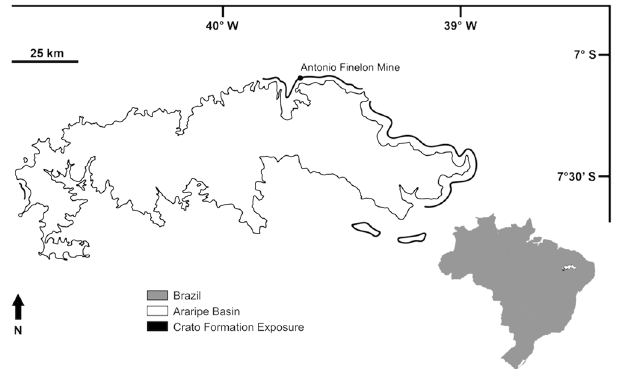
Figure 1. Locality map. Antônio Finelon Mine, Nova Olinda municipality, Ceará State, Brazil. Outcrops of the Crato Formation and of the Araripe Basin are also